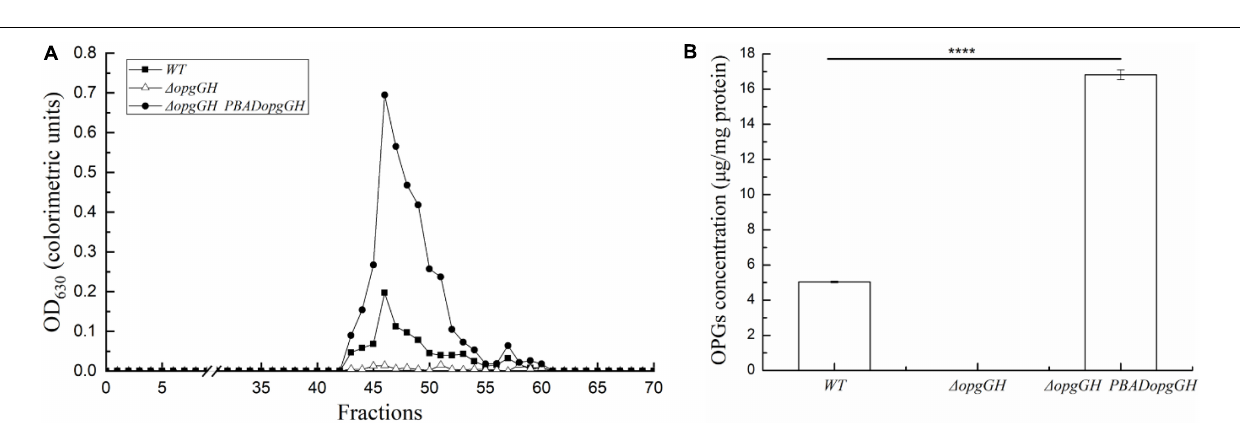
FIGURE 2 | Purification and quantification of OPGs from Y. enterocolitica . OPGs were extracted from wild-type, (cid:49) opgGH and (cid:49) opgGH -P BAD opgGH strains grown to the exponential phase in LNNS medium supplemented with 0.6 g/L L -arabinose. (A) Gel filtration chromatography of OPGs. (B) Quantification of purified OPGs. The data are presented as the mean ± SD of at least three independent experiments. An asterisk indicates a significant difference with **** P <